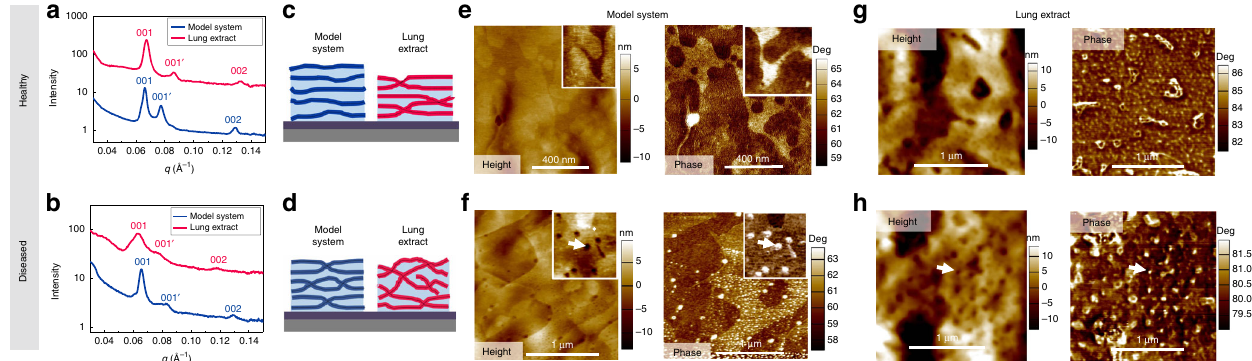
Fig. 5 1D GISAXS and AFM of model systems and lung extracts. 1D GISAXS intensity versus reciprocal space q ( Å (cid:3) 1 ) pro fi les for BLES samples and model membrane systems in healthy ( a ) and diseased ( b ) states. The middle panels are schematic representation of stalks and orientation in healthy ( c ) and diseased ( d ) model (blue) and BLES (magenta) membrane systems. The space between bilayers (light blue) represents water layers. AFM height and phase images of healthy ( e ) and diseased ( f ) model membrane systems are represented in the fi gure. Inset in the healthy model ( e ) is 250 nm × 250 nm while inset in the diseased model ( f ) highlighting the pores in the diseased model system is 500 nm × 500 nm, white arrows point to pore-like defects. Height and phase AFM images of lung extract (BLES) in healthy ( g ) and diseased ( h ) states are